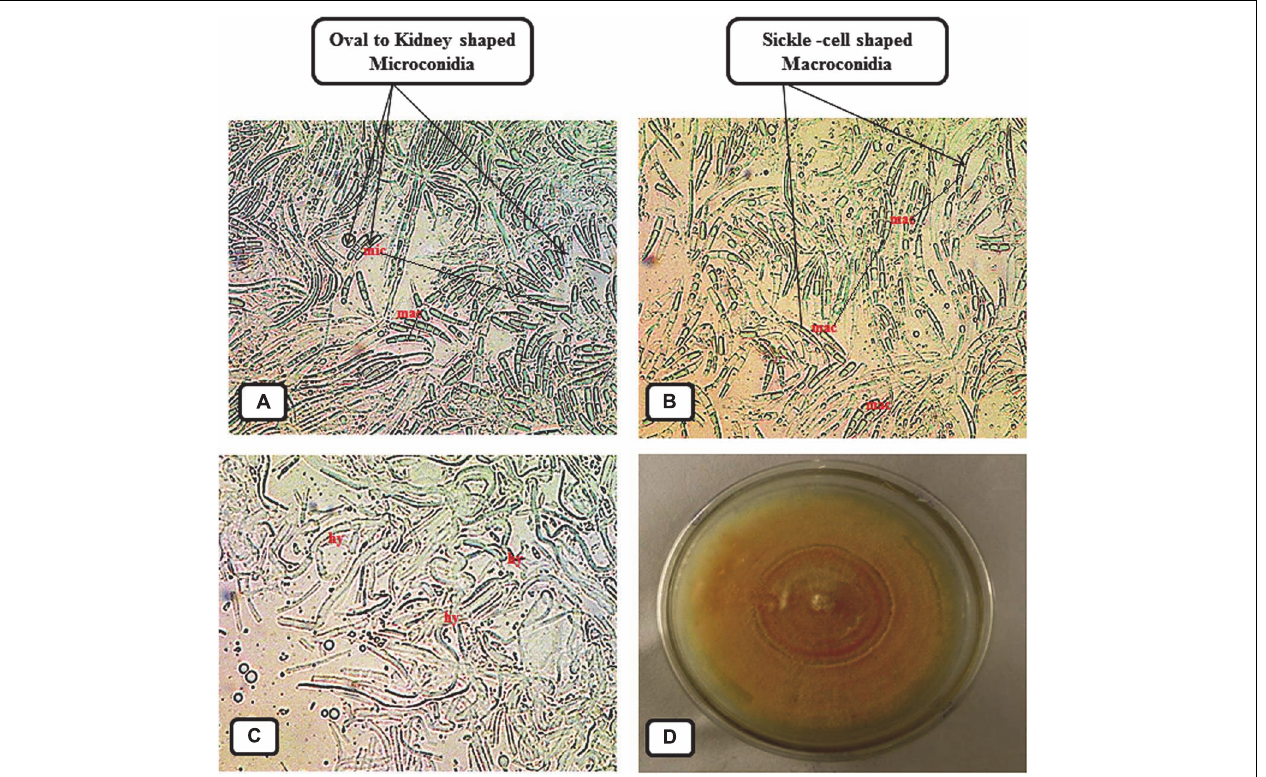
FIGURE 1 | Photograph showing morphological and cultural characteristic of the vascular wilt pathogen Fusarium oxysporum f. sp. lycopersici ( Fol ) maintained on Potato Dextrose Agar (PDA) medium. (A) Microscopic observation of the small, oval or kidney shaped, and one or two celled, Microconidia (Abbreviation: mic) present in between the larger sickle shaped Macroconidia. (B) Microscopic view of the sickle-shaped, thin walled and delicate Macroconidia (Abbreviation: mac). (C) Structure of the fungal mycelium composed of interwoven hyphal filaments (Abbreviation: hy). (D) Photograph showing cultural characteristic and growth pattern of the Fol pathogen grown on